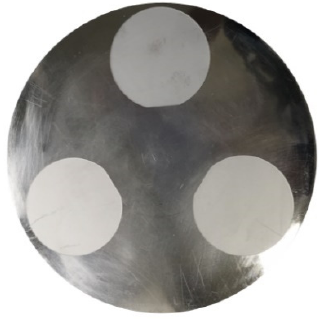
Figure 2. The distribution of the sapphire wafers on the carrier plate .